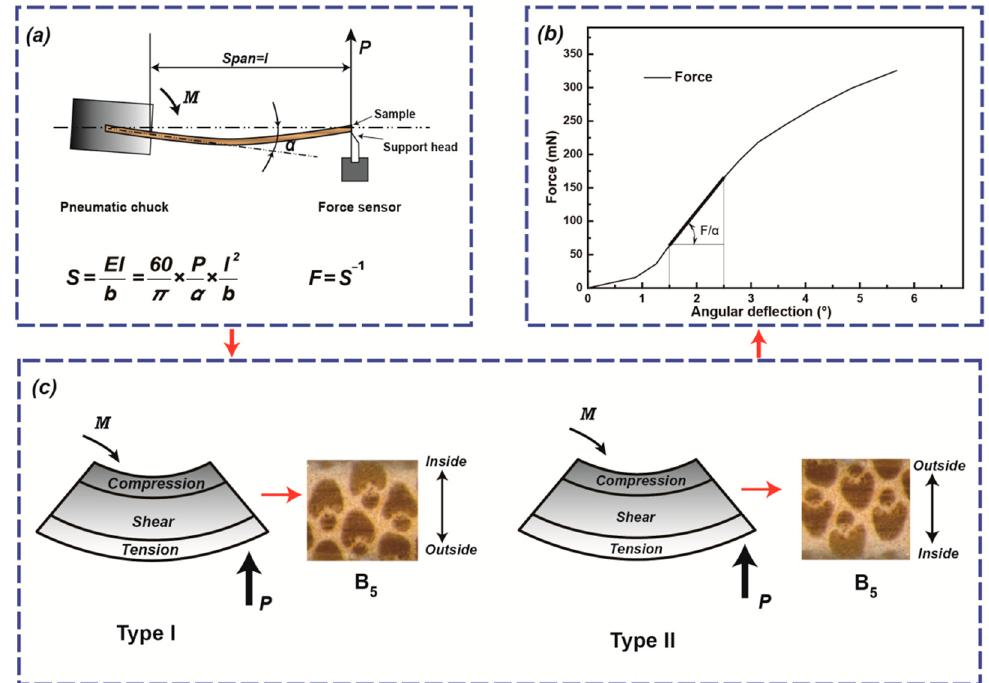
Figure 4. ( a ) the schematic of the bending flexibility test based on the beam-bending principle; ( b ) a typical curve of force versus angular deflection ( P- α ) of specimen with the span thickness ratio ( l/h ) = 50; ( c ) specimen (B5 as an example) loaded by Types I and II.